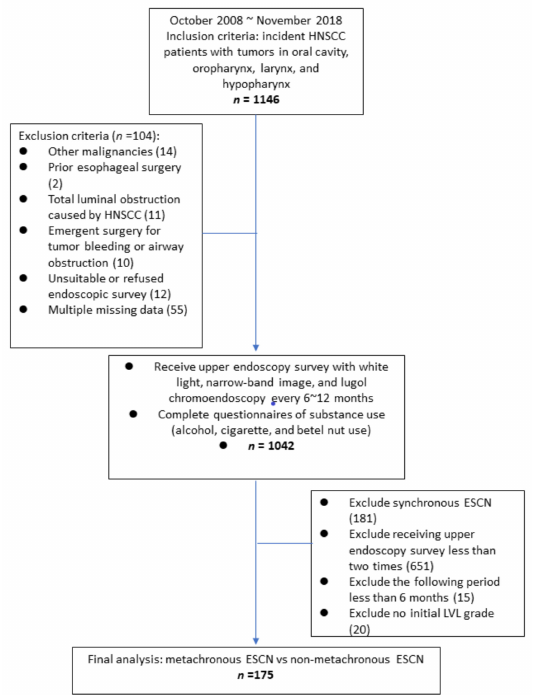
Figure 3. Flow chart of metachronous ESCN. Abbreviations: ESCN, esophageal squamous cell neoplasm; HNSCC, head and neck squamous cell